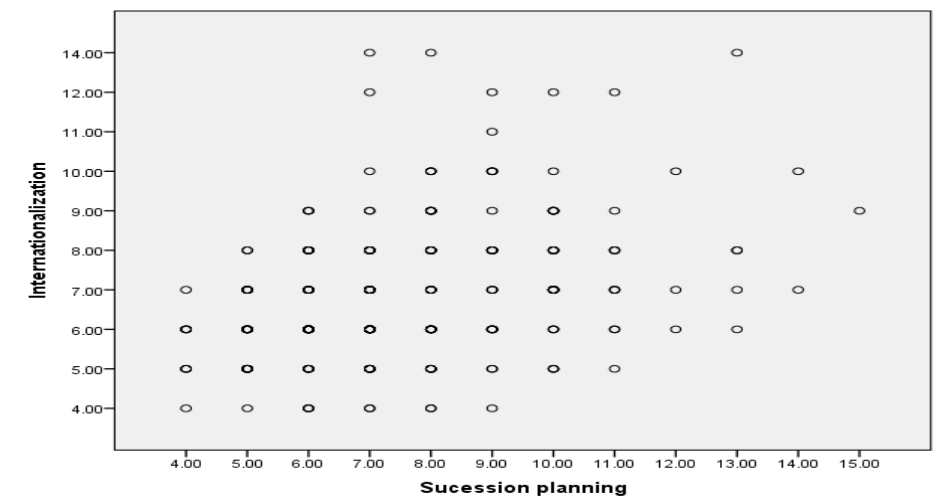
Fig. 3. Scatter plot of succession planning and internationalisation scores (The Authors’ Fieldwork Computation,